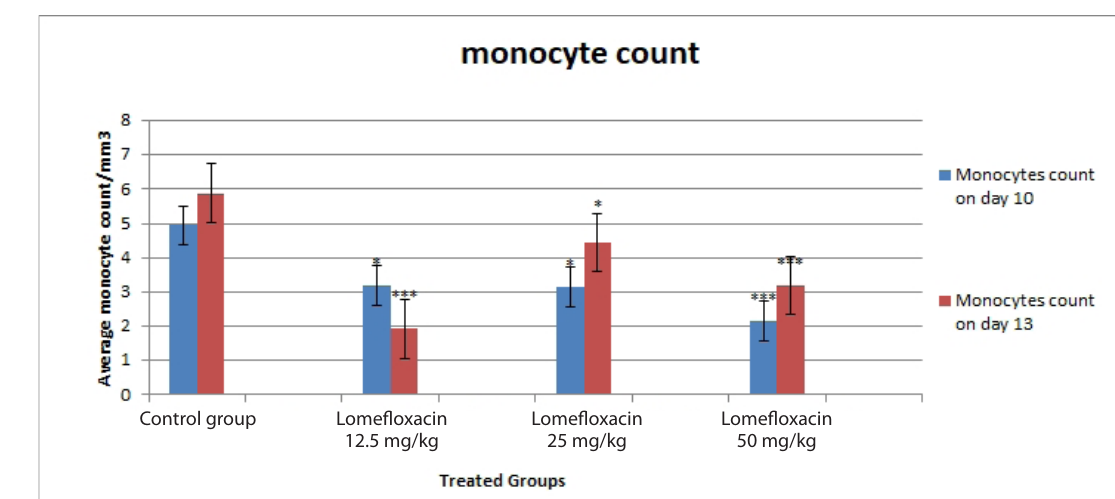
FIGURE 2 (C ) - Monocytes count before and after cyclophophamide administration.